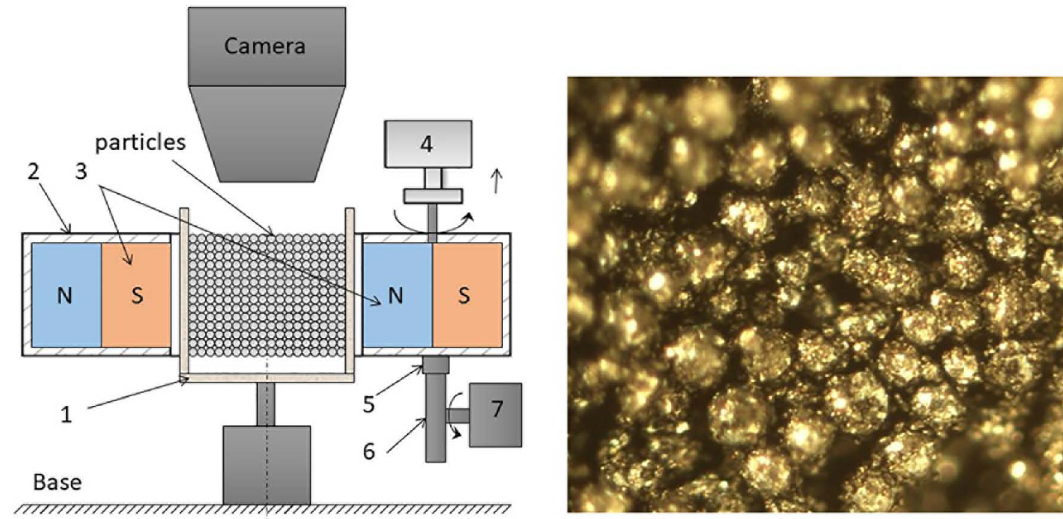
Figure 1. ERMF lab setup and flat sample.